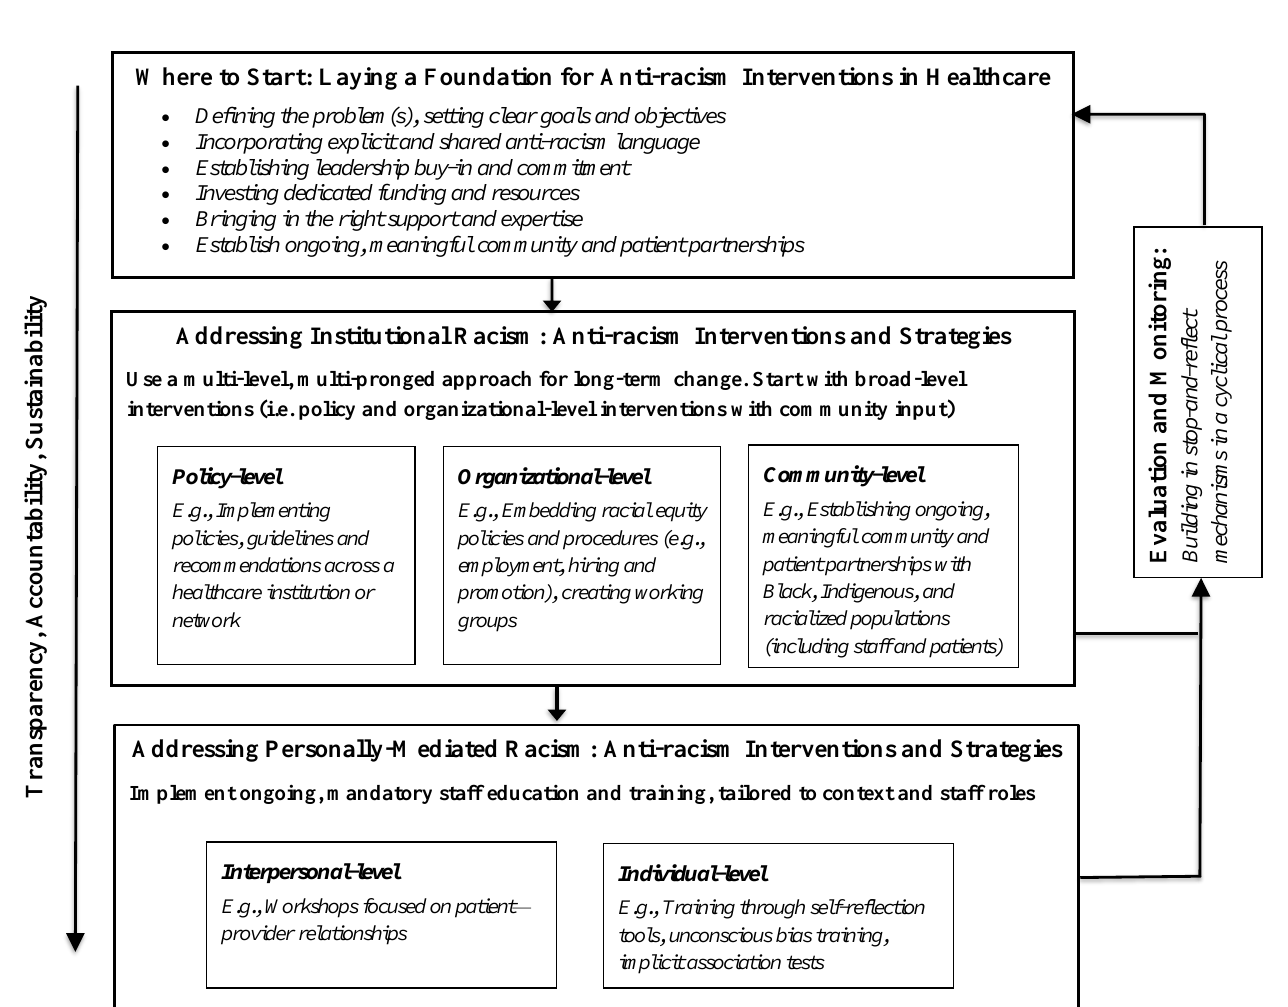
Figure 2. Overview of the principles and strategies for anti-racism interventions in healthcare